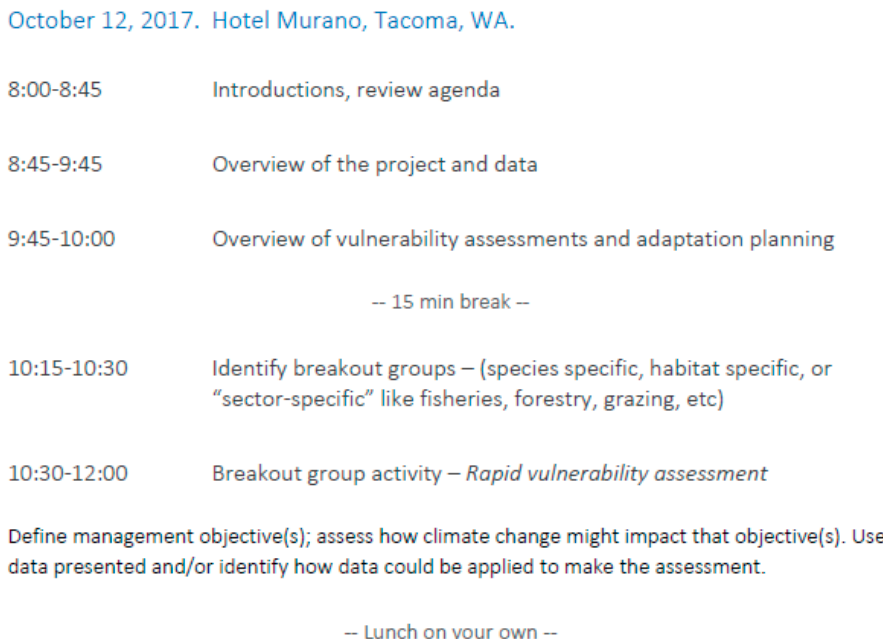
Figure A1. Stakeholder Workshop Agenda, 12 October 2017, Tacoma, Table A1. Tribally important ecosystem. services and species.